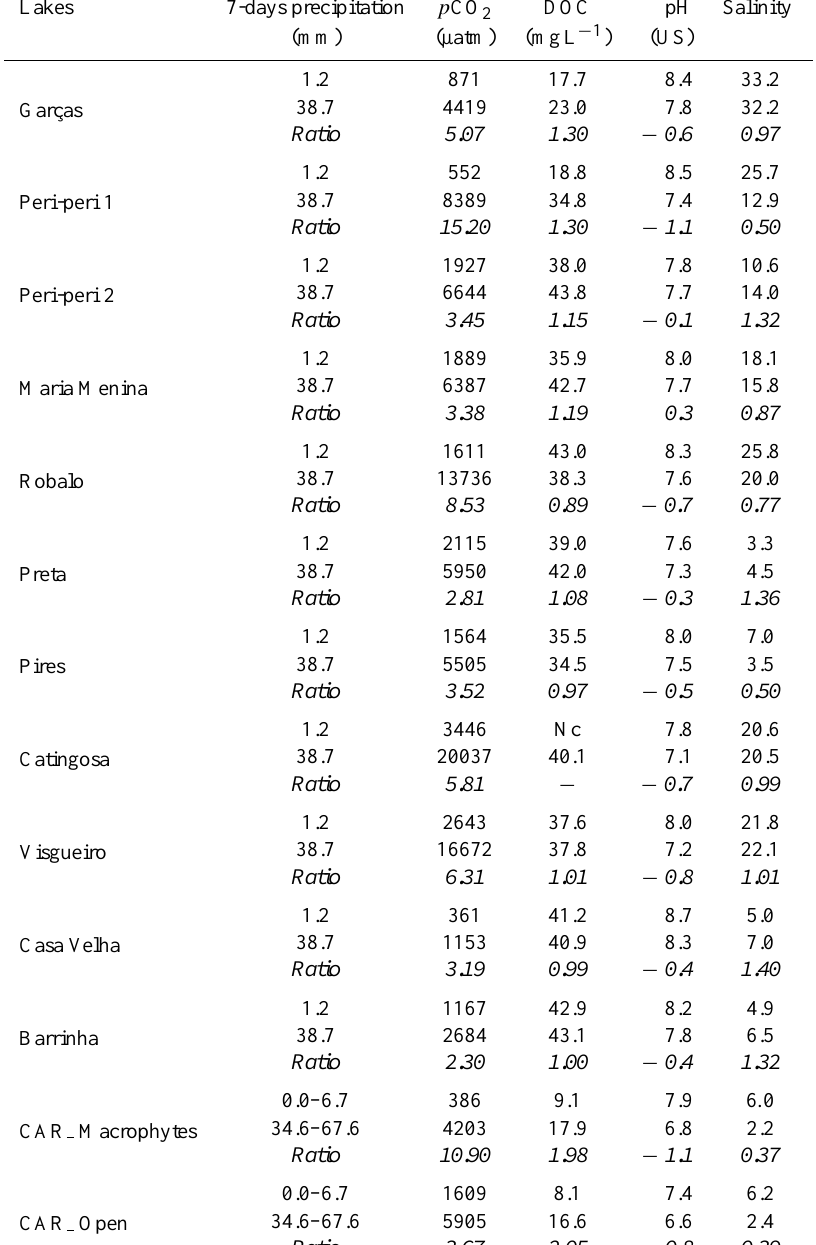
Table 2. Daily-average values of p CO 2 , DOC, pH and salinity after periods of high and low weekly-accumulated precipitation events for each studied lake, and the ratio of high rainfall to low rainfall